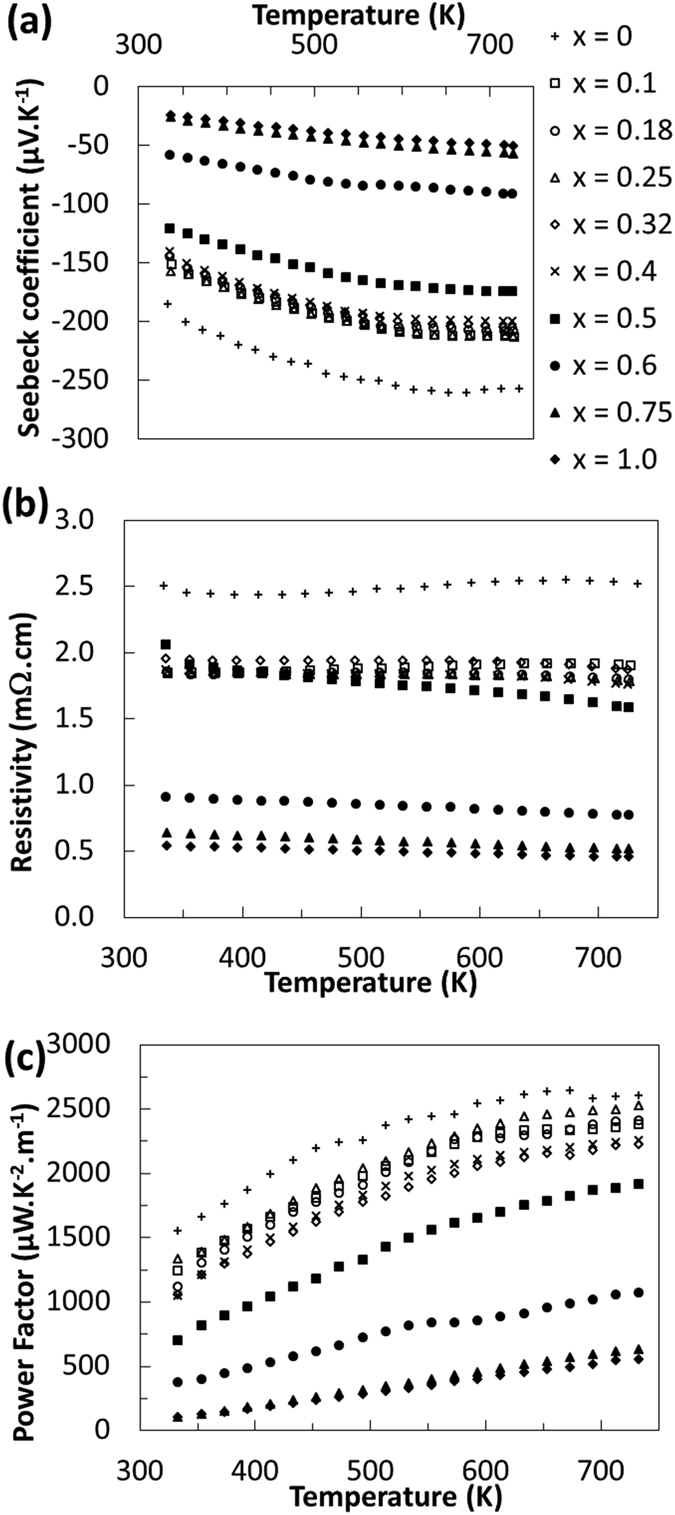
Electronic transport properties of CoSbS1−xSex doped with Te.(a) Seebeck coefficient,(b) electrical conductivity, and(c) Power Factor as a function of x and the temperature of measurement.